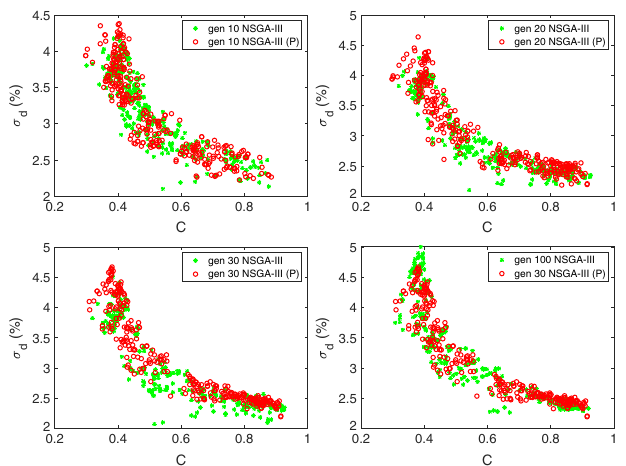
FIG. 9. Projection of the Pareto-optimal front obtained by the NSGA-III and NSGA-III (P) with a population size of 300 in different generations.